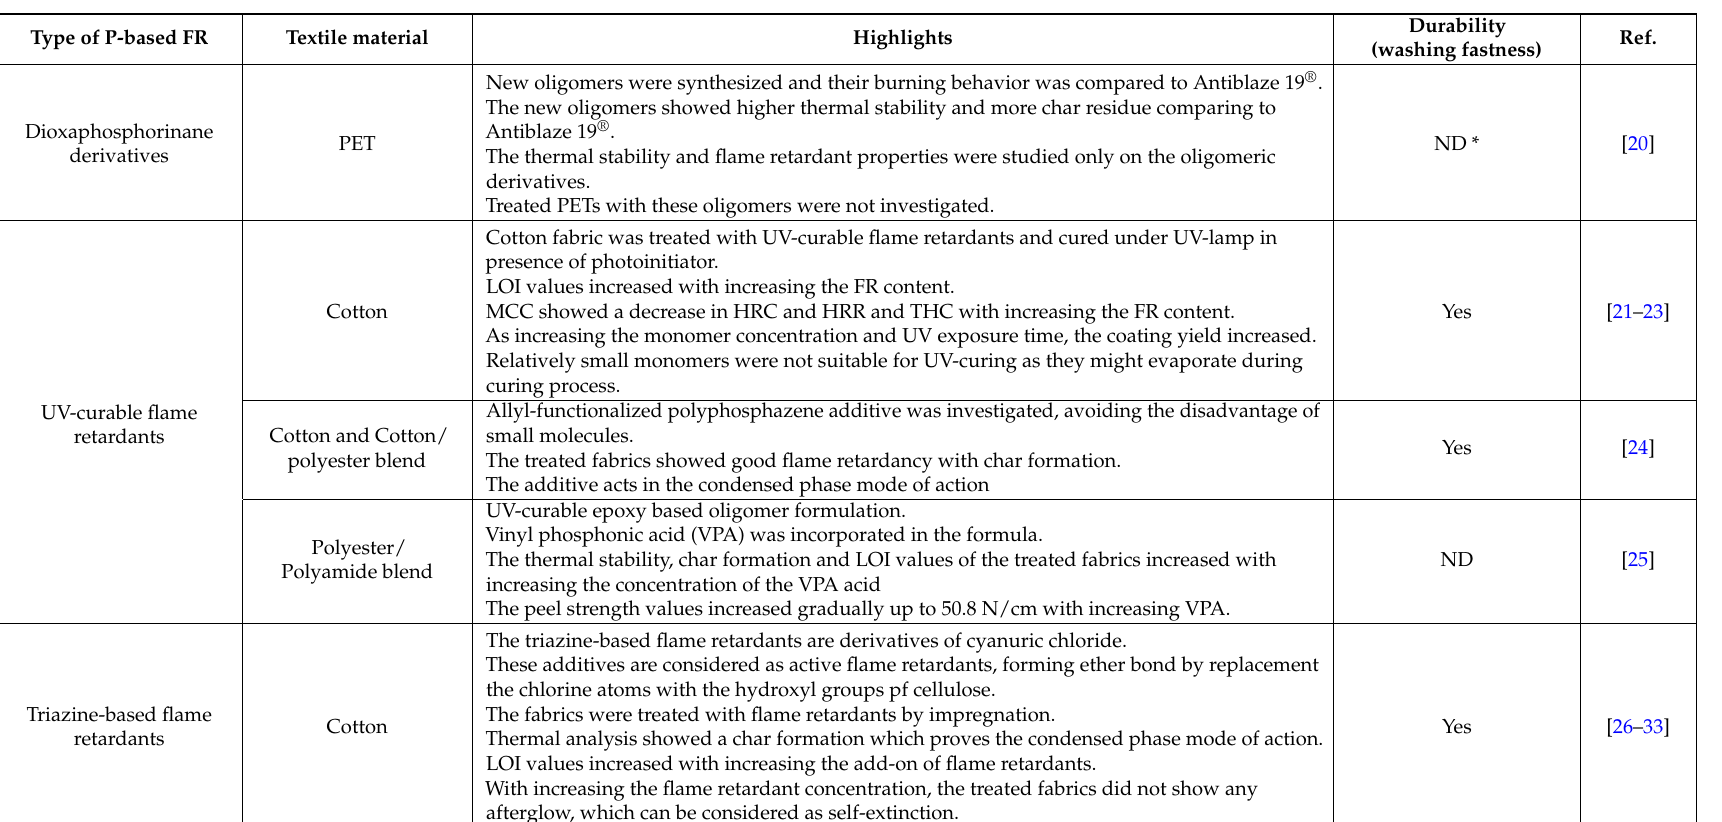
Table 1. Main results achieved by treating fabrics with phosphorus-based flame